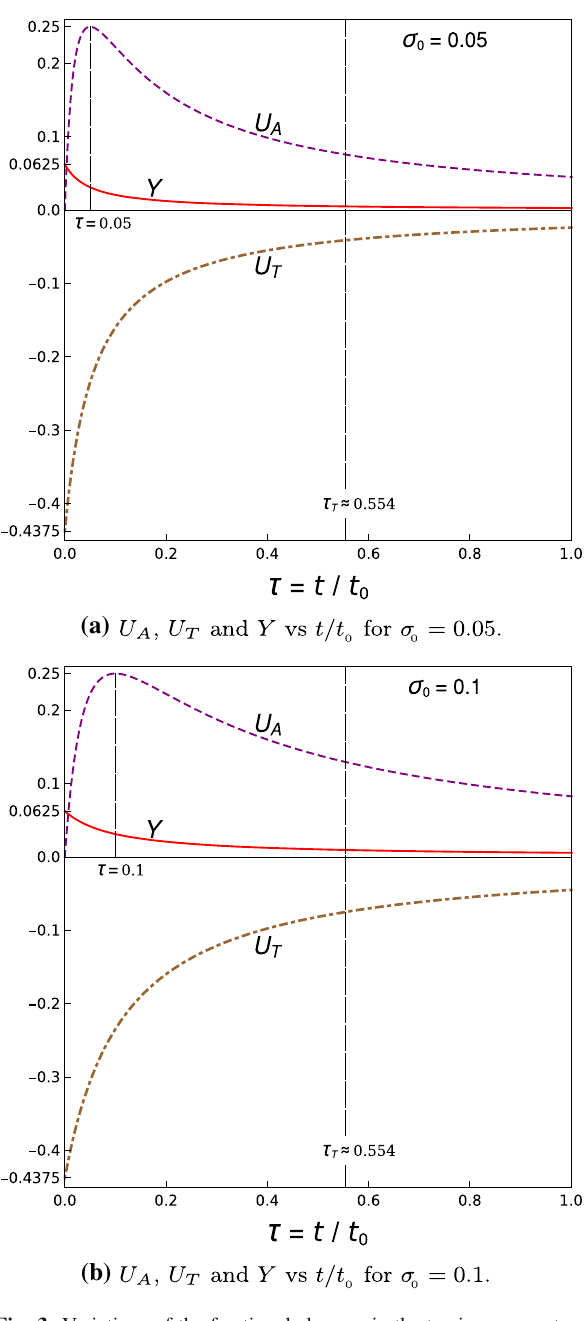
Fig. 3 Variations of the fractional changes in the torsion parameters, viz. U A (τ) and U T (τ) , and their resultant Y (τ) , for fixed parametric = 0 . 05 and b σ = 0 . values: a σ 0 0